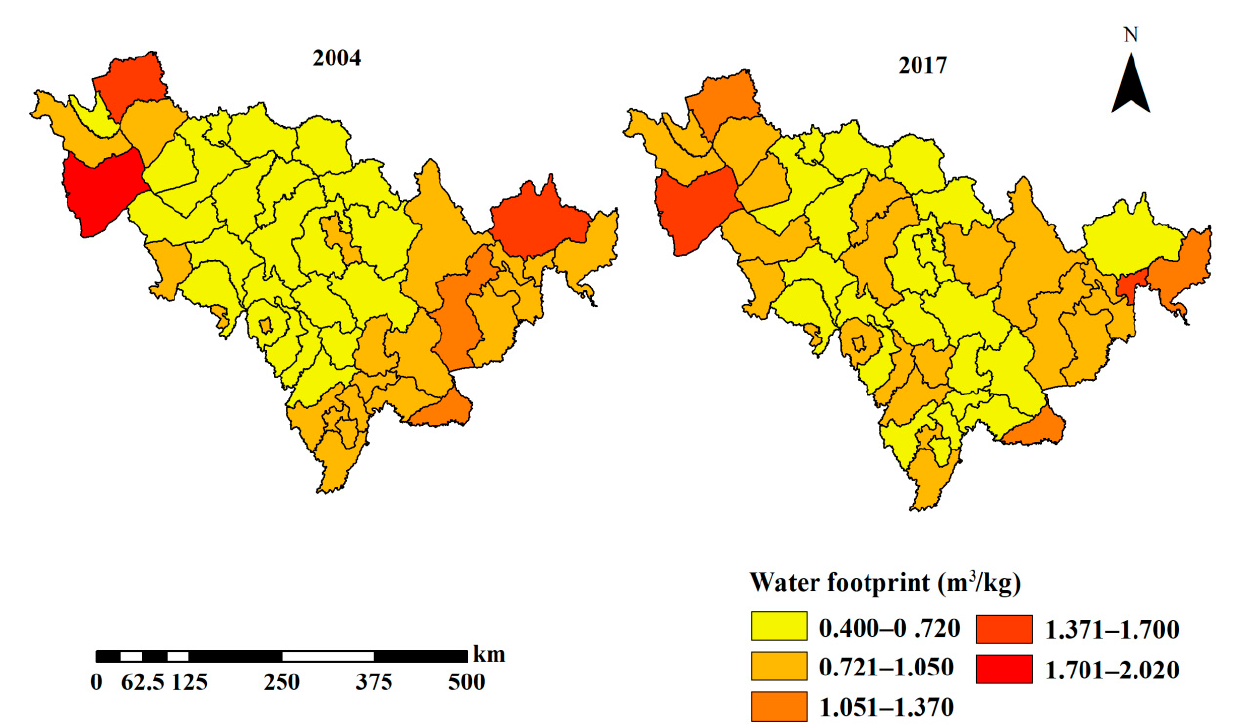
Figure 7. Spatial distributions of the total WFs of maize production in 2004 and 2017. The total WF of maize production in Jilin Province was mainly composed of the green WF, followed by the gray WF; the blue WF contributed the least to the total WF (Figure 8). In 2004, the areas with high values of blue WFs were mainly distributed in western Jilin Province because there was less rainfall in the west, and the region thus required more irrigation water. The blue WF values decreased from west to east, and there was no irrigation in the eastern region because of the abundant precipitation. The green WFs were related to the local precipitation and yield; thus, high green WFs were mainly distributed in the east. The gray WFs were higher in the eastern and western regions than in the middle east and middle regions. The gray WF of maize production was mainly affected by the amount of N fertilizer used and the yield. The amount of fertilizer used in maize production in Jilin Province differed among the regions, decreasing gradually from west